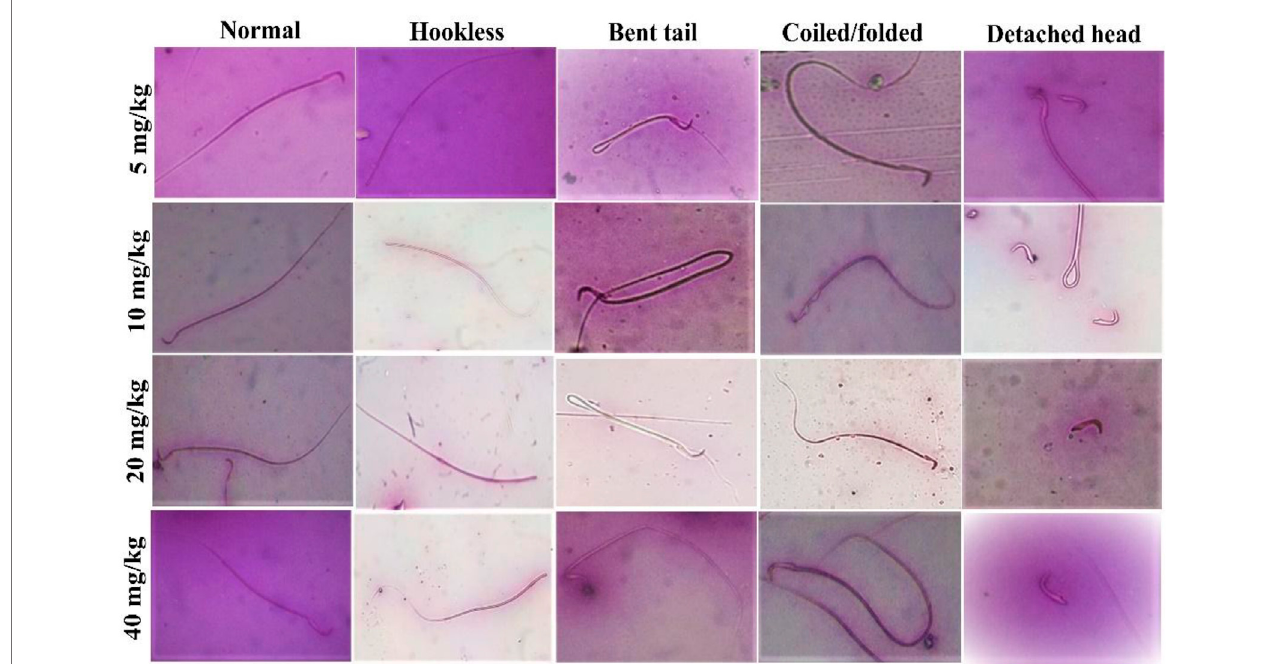
FIGURE 12 | Pictorial view of morphological parameters of sperm.